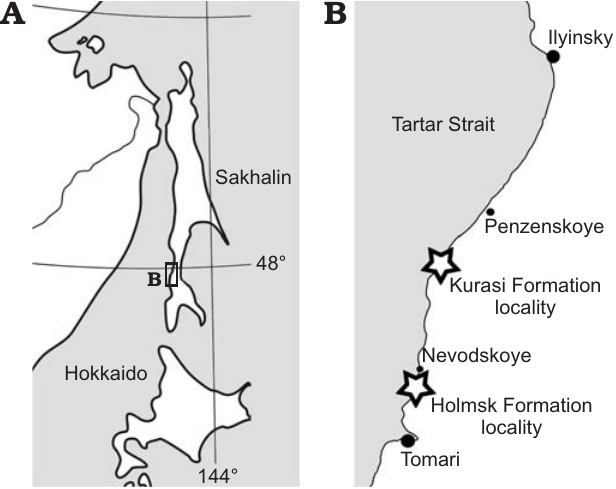
Fig. 1. Location of the Sakhalin Island ( A ) and sketch map of the studied area ( B ) showing the fossil fish localities